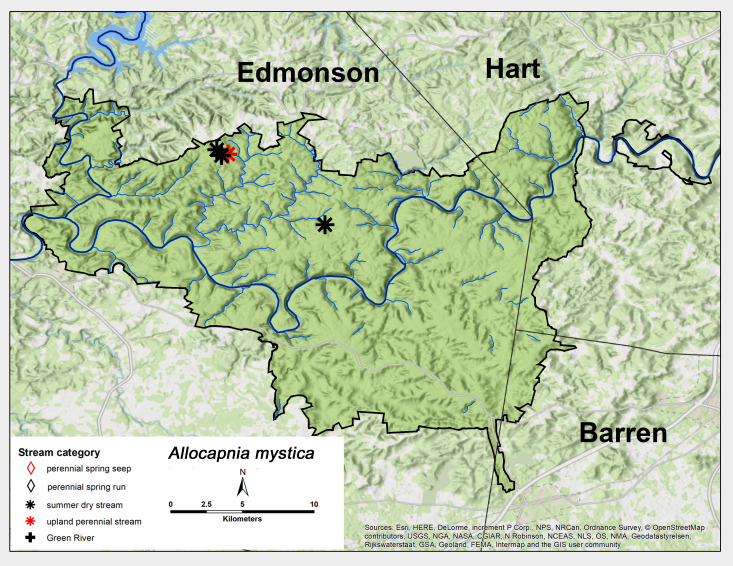

Allocapnia
mystica